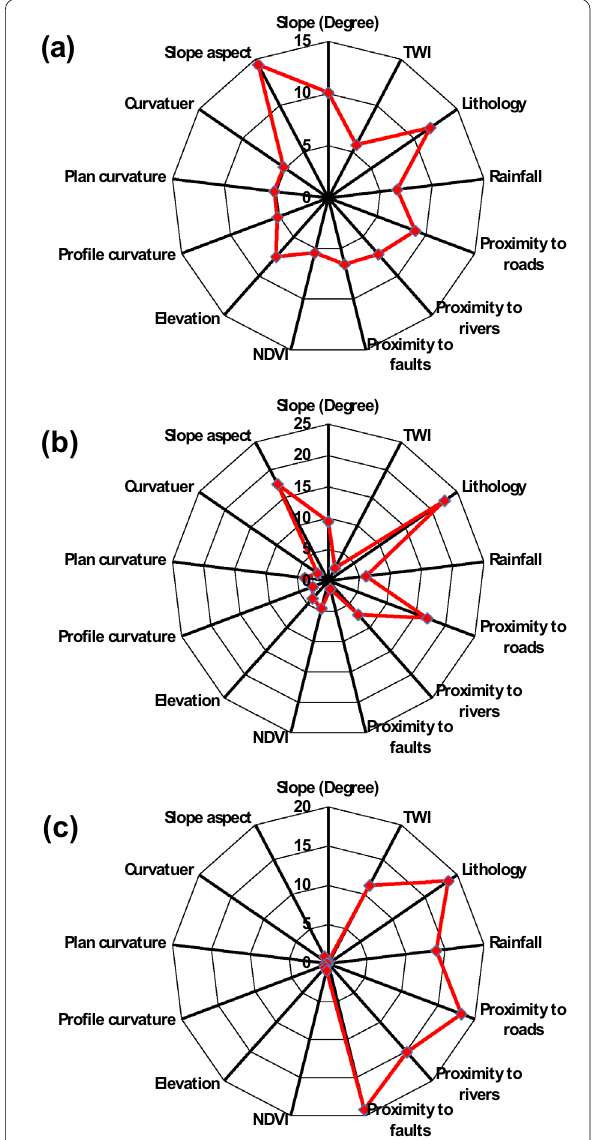
Fig. 9 Proportional importance of causative factors derived